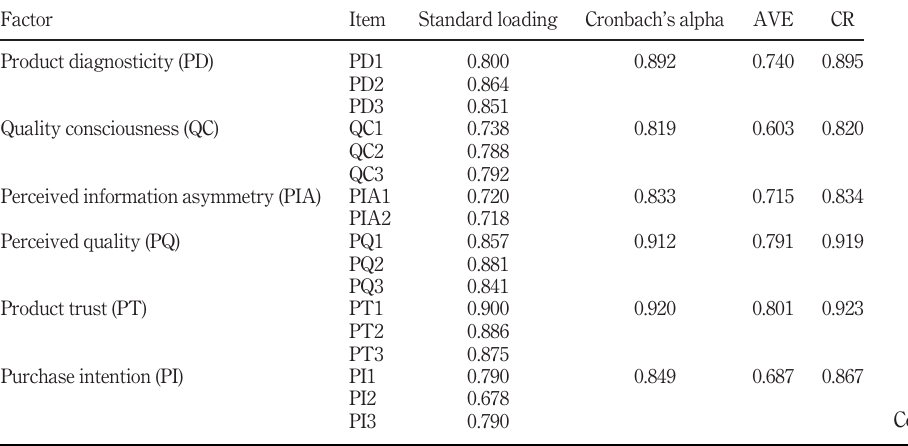
Table 1. Convergent